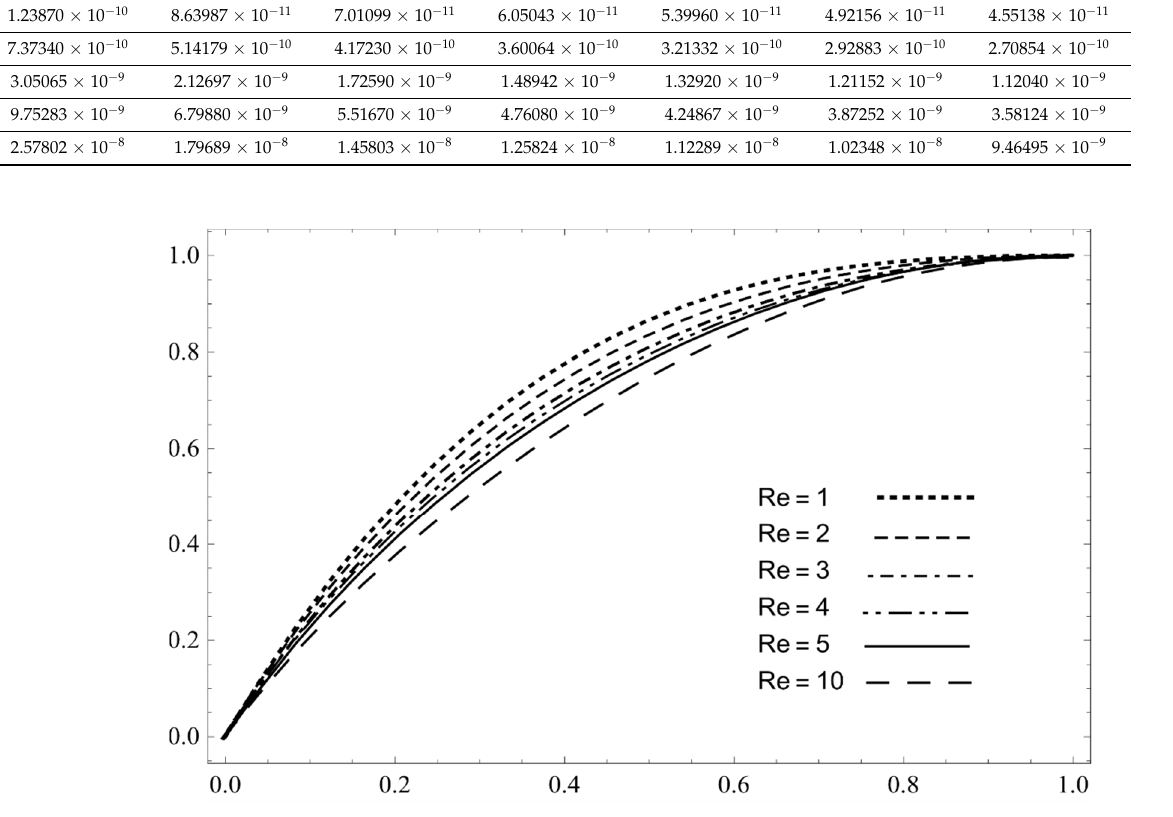
Figure 10. Behavior of f ( y ) using RKHSM with α = 1.